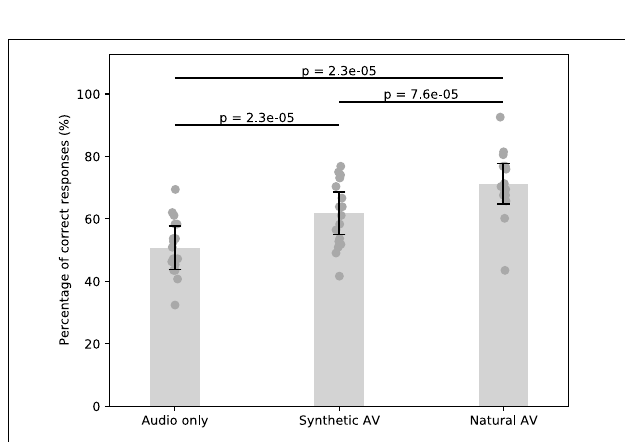
FIGURE 5 | Speech comprehension in noise without a visual signal, with the synthesized facial animations, as well as with the natural AV signals. Error bars represent the standard error of the mean, and the dark gray points show the average score per